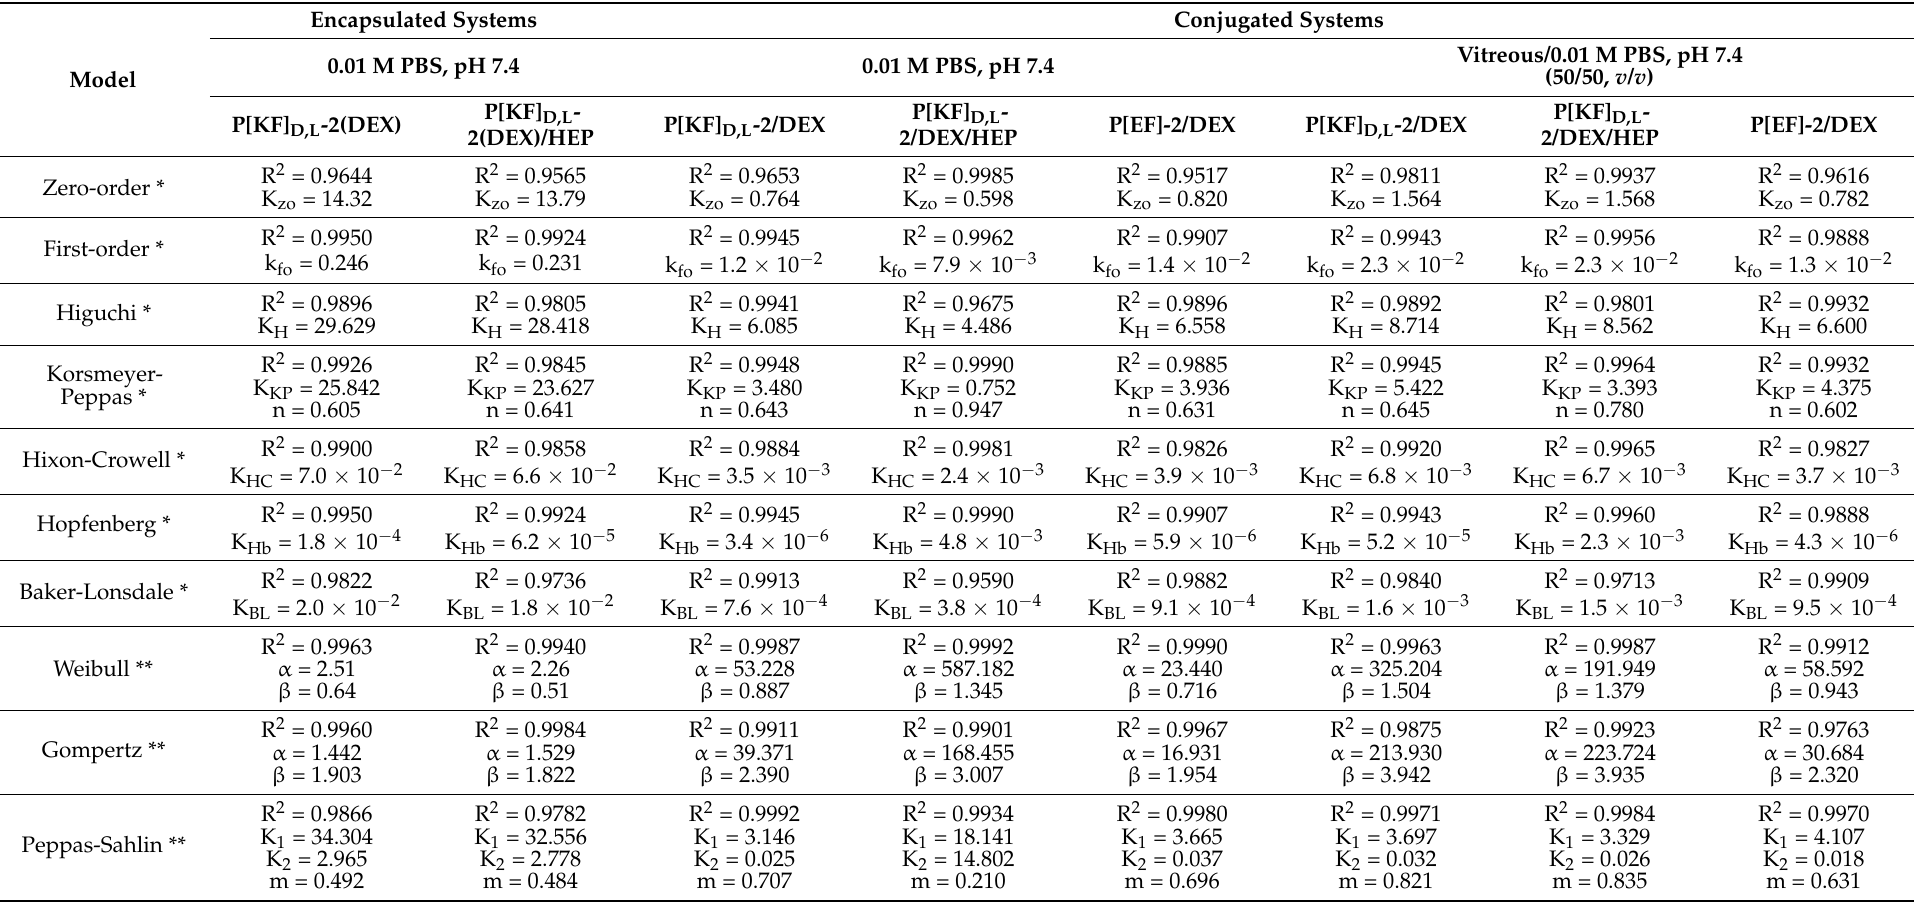
Table 6. Correlation coefficients and model parameters were obtained for DEX release profiles of encapsulated and conjugated delivery systems in buffer